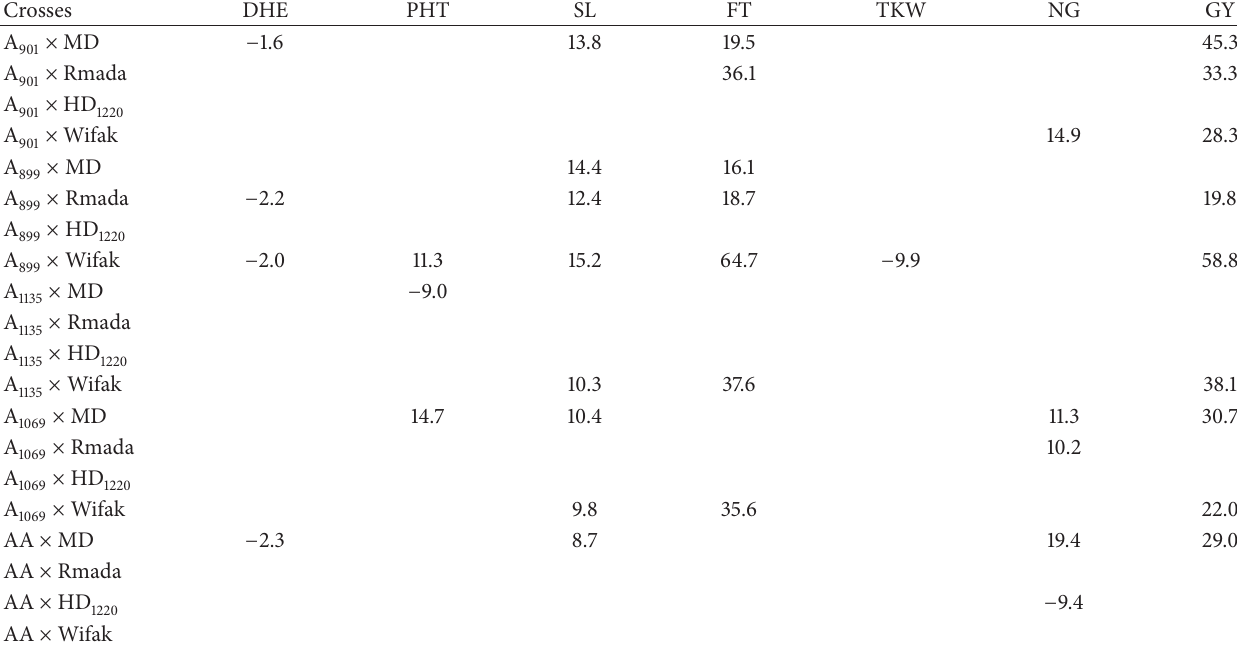
Table 7: Significant mid-parent heterosis (%) for seven traits in bread wheat genotypes. Crosses